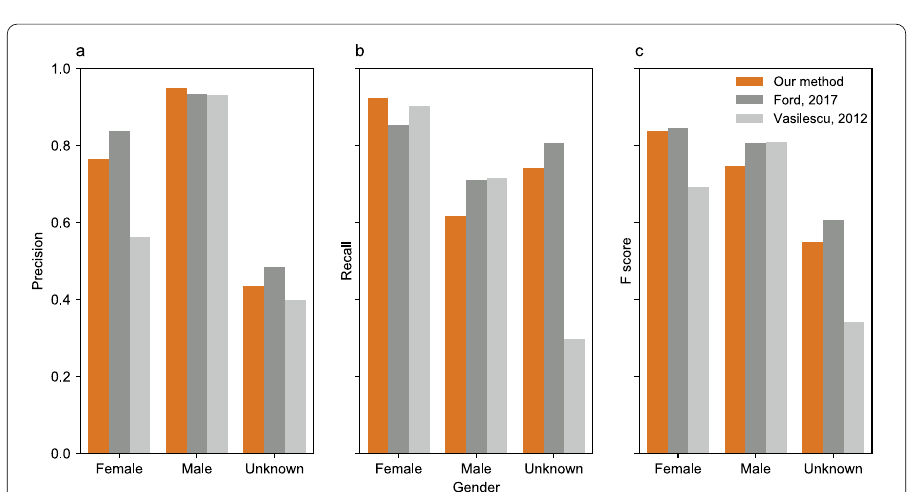
Figure 2 Comparing gender inferring algorithms. Accuracy of our gender inference against a baseline and two alternative methods. Precision ( a ) measures for each category how many categorized items are relevant, and recall ( b ) captures how many relevant items are selected from all good ones, F score ( c ) takes the harmonic average of precision and recall, reaches 1 when both metrics are perfect